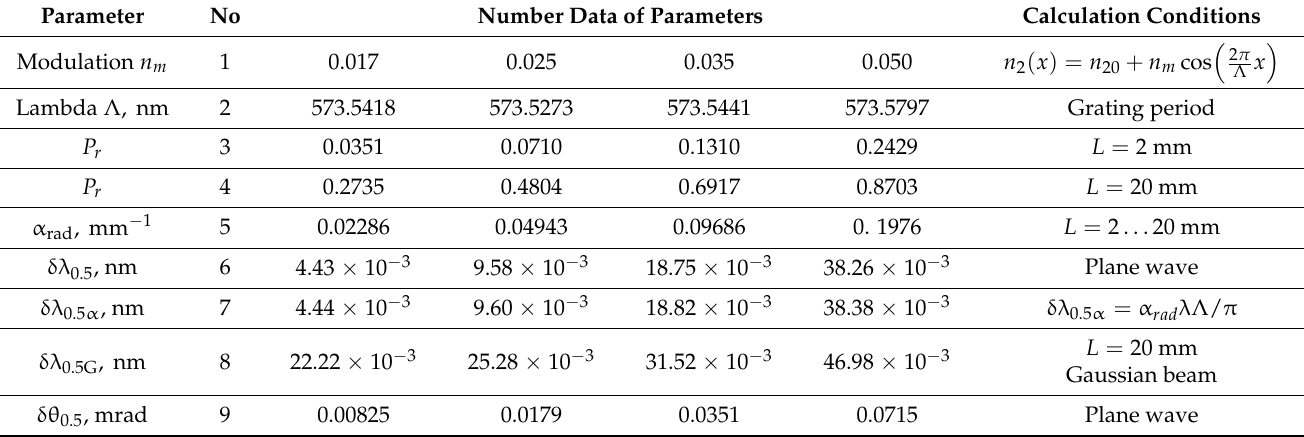
Table 2. Calculation results of grating properties under waveguide resonance at 4 values of n m for plane wave and Gaussian